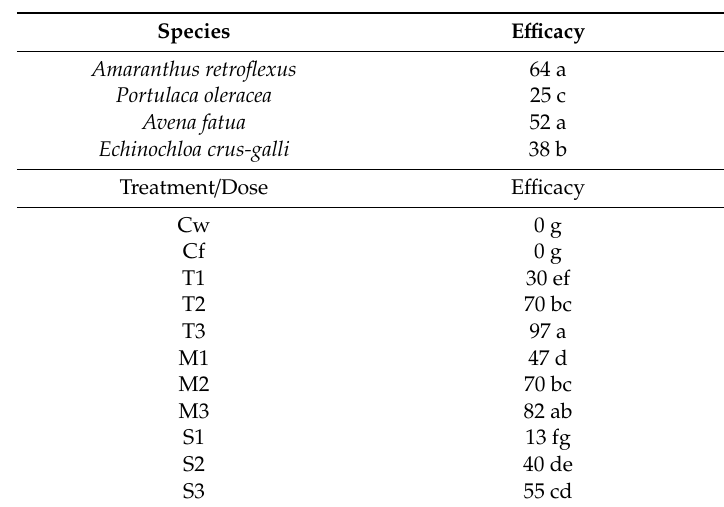
Table 6. Overall essential oils (EOs) e ffi cacy per species and per treatment. Treatments were: T. capitata EO (T1, T2 and T3 are 4, 8 and 12 µ L mL − 1 doses), M. piperita EO (M1, M2 and M3 are 12, 16